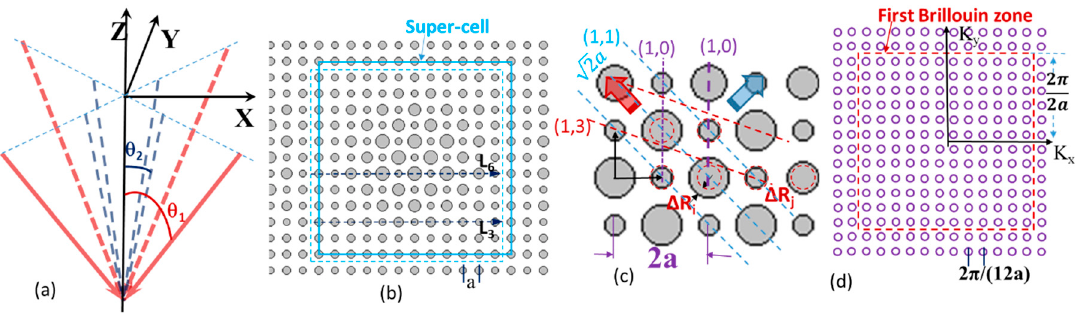
Figure 1. ( a ) Schematic of eight beams arranged in a cone geometry. ( b ) Designed patterns for E-beam lithography for the generation of GPSC with a unit cell size of 12a × 12a. ( c ) Enlarged view of the pattern in ( b ) with labels of lattice planes. ( d ) Fractional orders of momentum increasing by 2 π / (12a) in the reciprocal space.